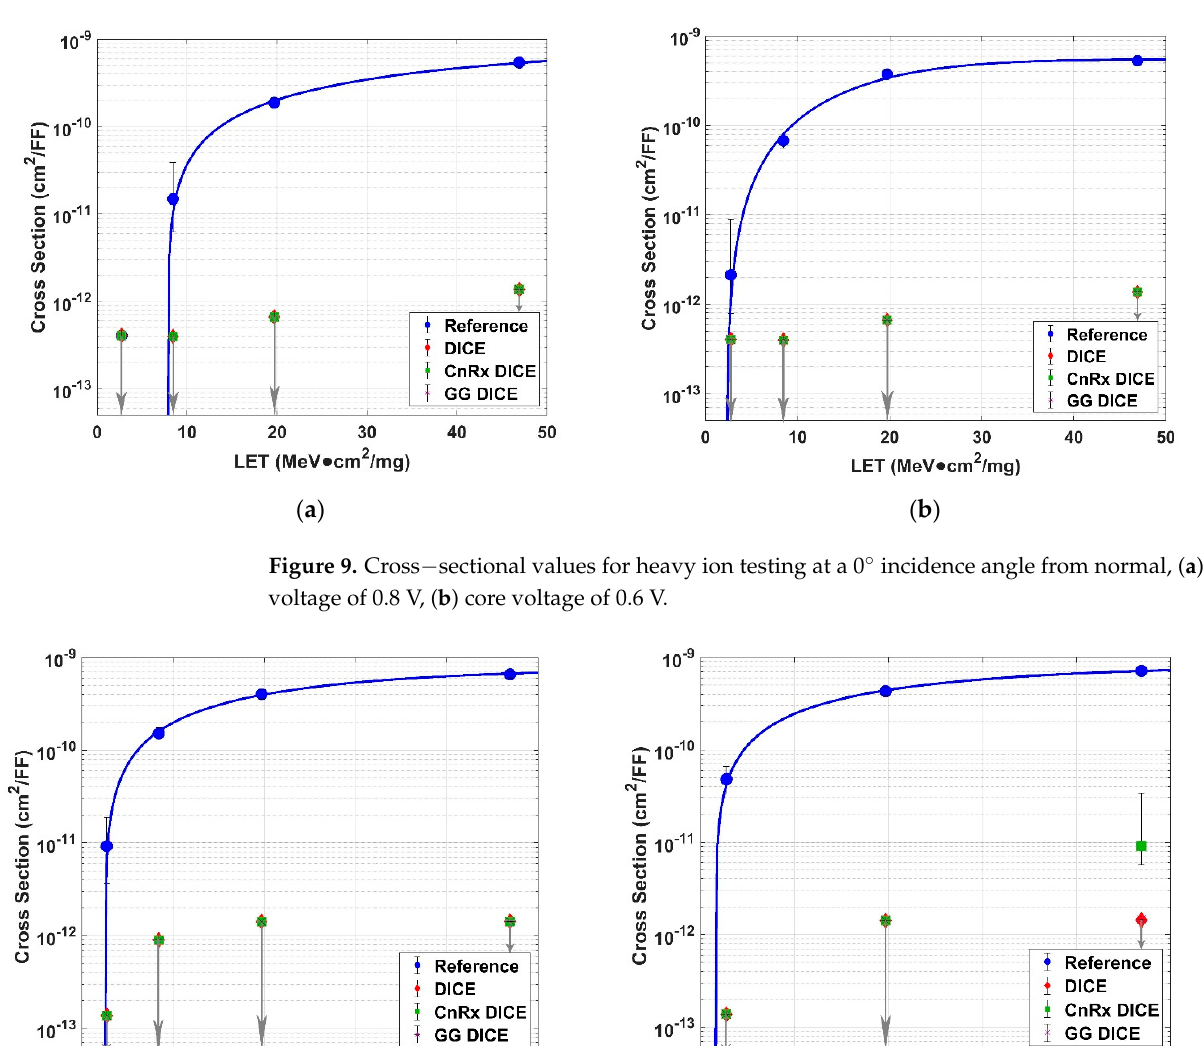
Figure 8. Heavy ion experimental setup at the TAMU Texas A&M University. The incident angle was set at 60° from normal.